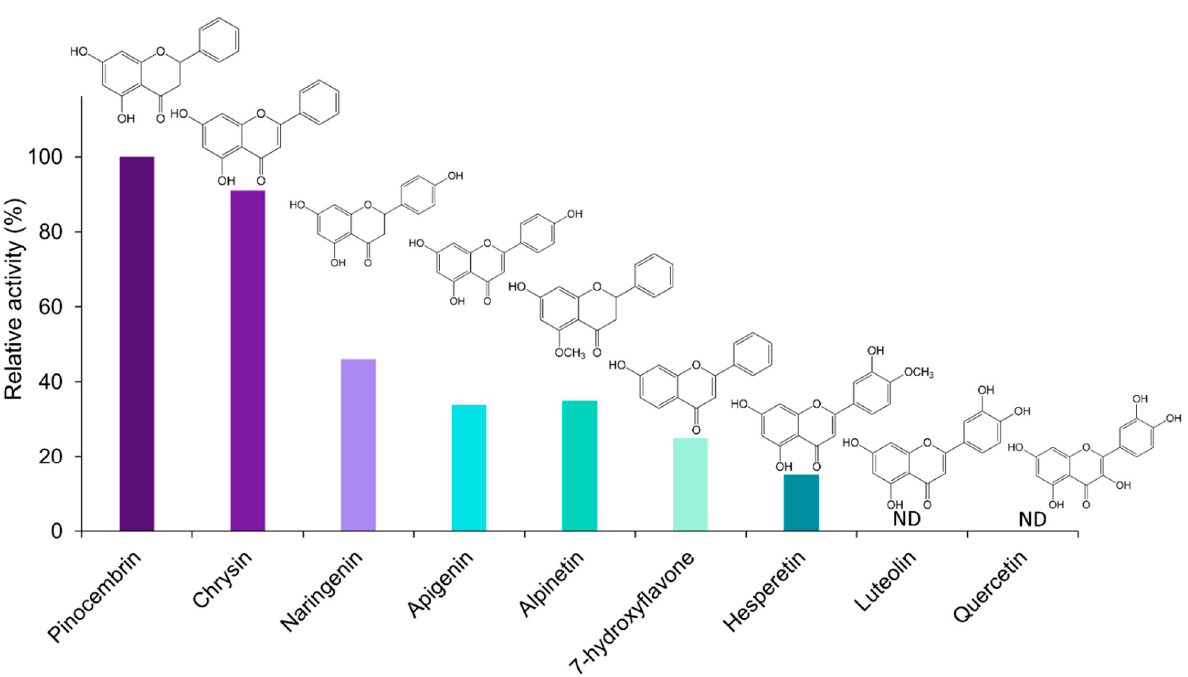
Figure 5. Relative activity (%) of EnOMT1 with various flavonoid compounds as substrate. Data were normalised to pinocembrin activity of 100%. All substrates were at 10 μ M and a saturating SAM (500 μ M) was used in all assays. ND = activity not detected.